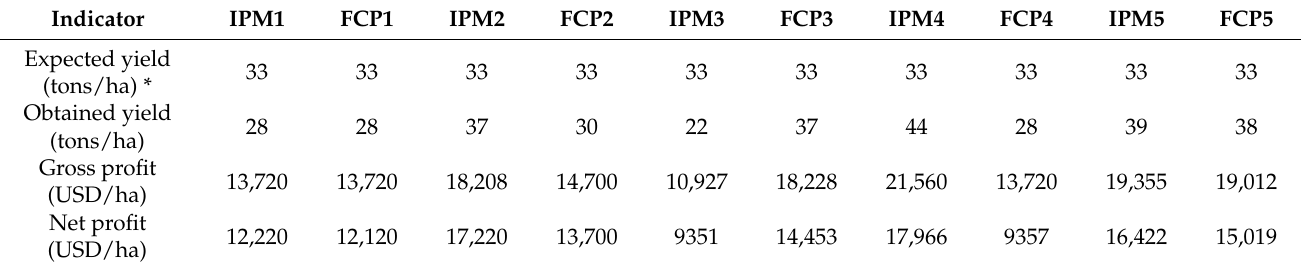
Table 4. Economic analysis of yields and profits from Costa Rican cabbage plots under different DBM management